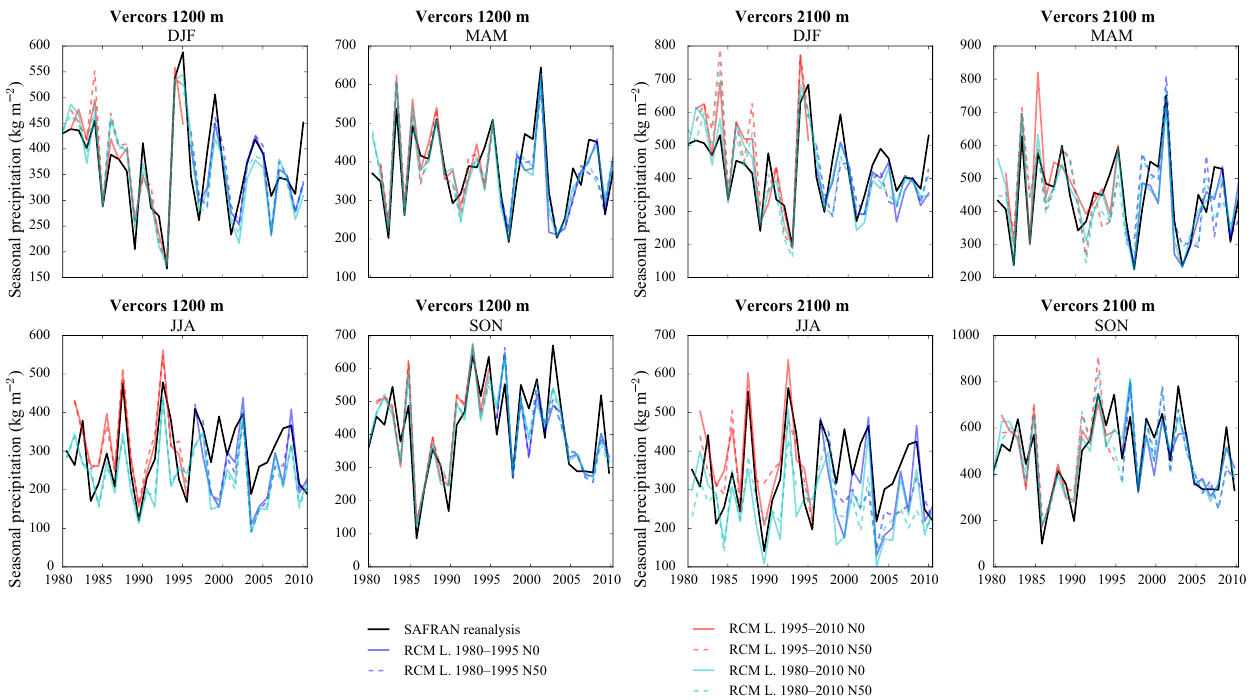
Figure 13. Seasonal average time series of precipitation from 1980 to 2010 in each adjusted RCM simulation and in the SAFRAN reanalysis for the Vercors massif at 1200 and 2100ma . s . l